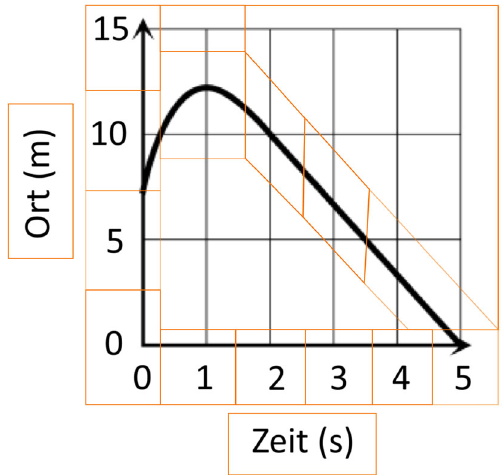
FIG. 2. Segmentation of the diagram of an exemplary item into different micro-AOIs. The axis labels are written in German and mean time (Zeit) and position